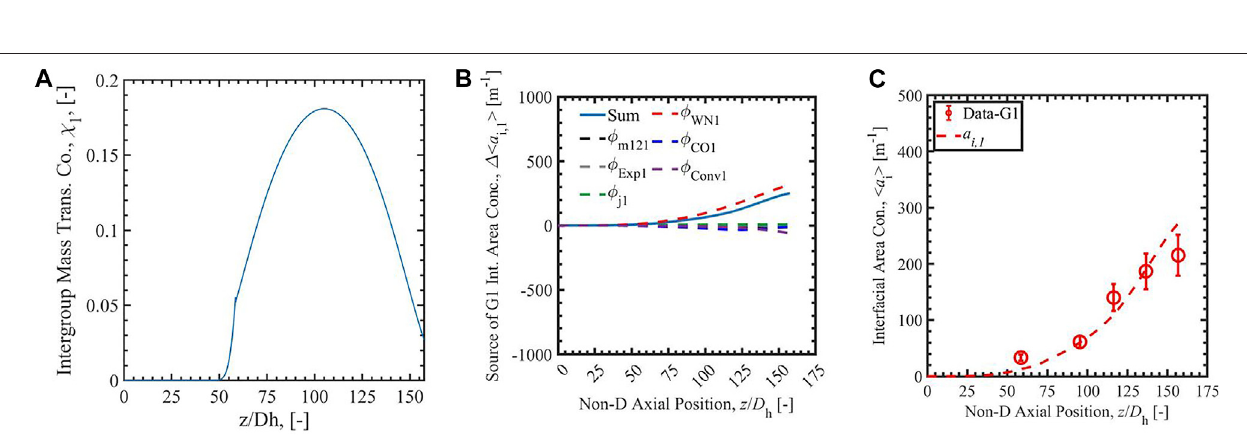
FIGURE 4 | The Run 1 results of group-1 intergroup mass transfer coef fi cient (A) , the source of group-1 interfacial area concentration (B) , and the interfacial area concentration (C) calculated with analytical-NT correlation (Zhu et al., 2020).